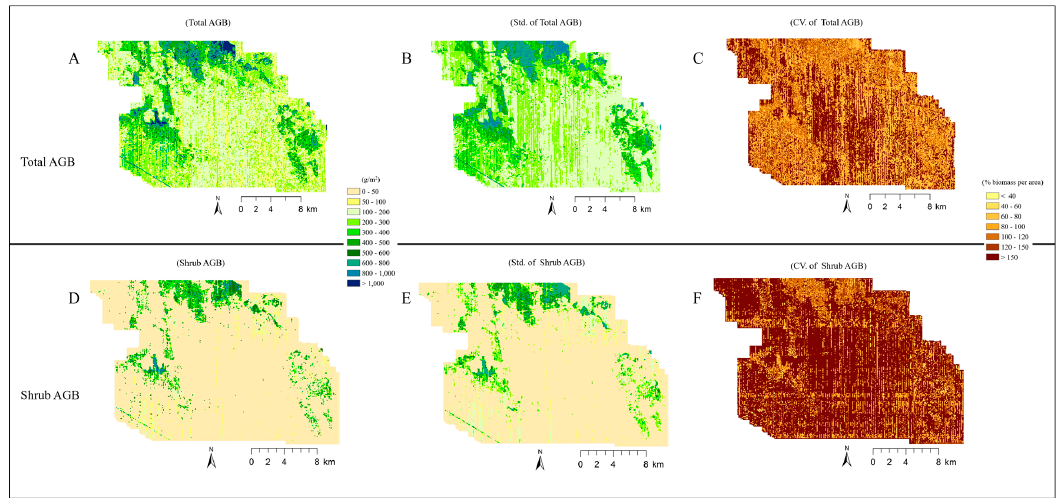
Figure 5. Imputed total AGB ( A ), standard deviation of the imputed total AGB ( B ) and coefficient of variation (CV) of the imputed total AGB ( C ) and imputed shrub AGB ( D ), standard deviation of the imputed shrub AGB ( E ) and coefficient of variation (CV) of the imputed shrub AGB ( F ), across a sub-area (middle portion) of the 2012 Lidar.